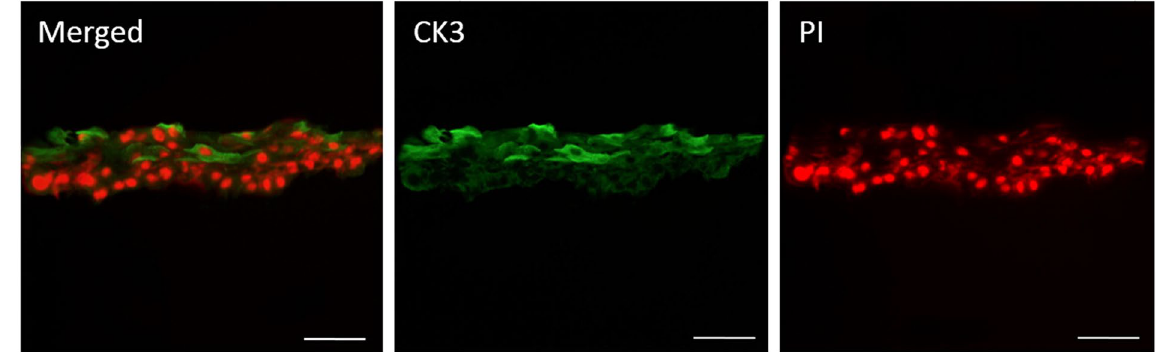
Figure 10. Fluorescent staining of histological cross sections of HCECs on the surface of hybrid constructs. Images show CK3 (green) and nuclei (red) in HCECs after culturing for 2 weeks. (scale bar, 100 μ